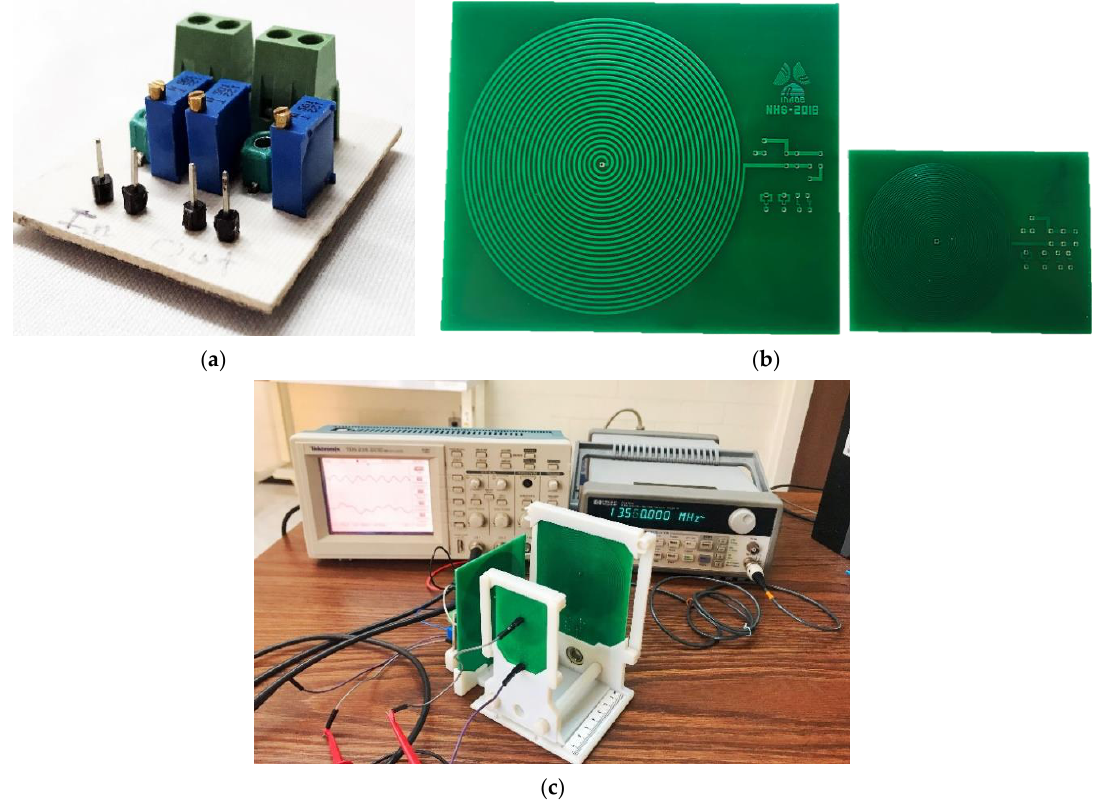
Figure 13. Modules manufactured on PCB-FR4 substrate. ( a ) Bridge circuit and ( b ) internal and external coils. ( c ) Configuration for measuring the coupling at 3.5 cm distance between the